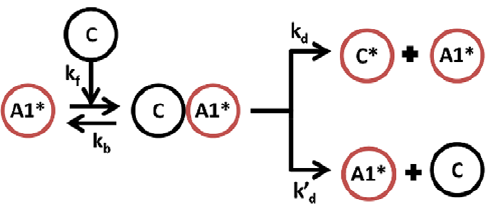
Figure 2. Addition of a new node in the minimal model. An inactive protein C is added, that can either become activated ( C (cid:2) ) by A (cid:2)